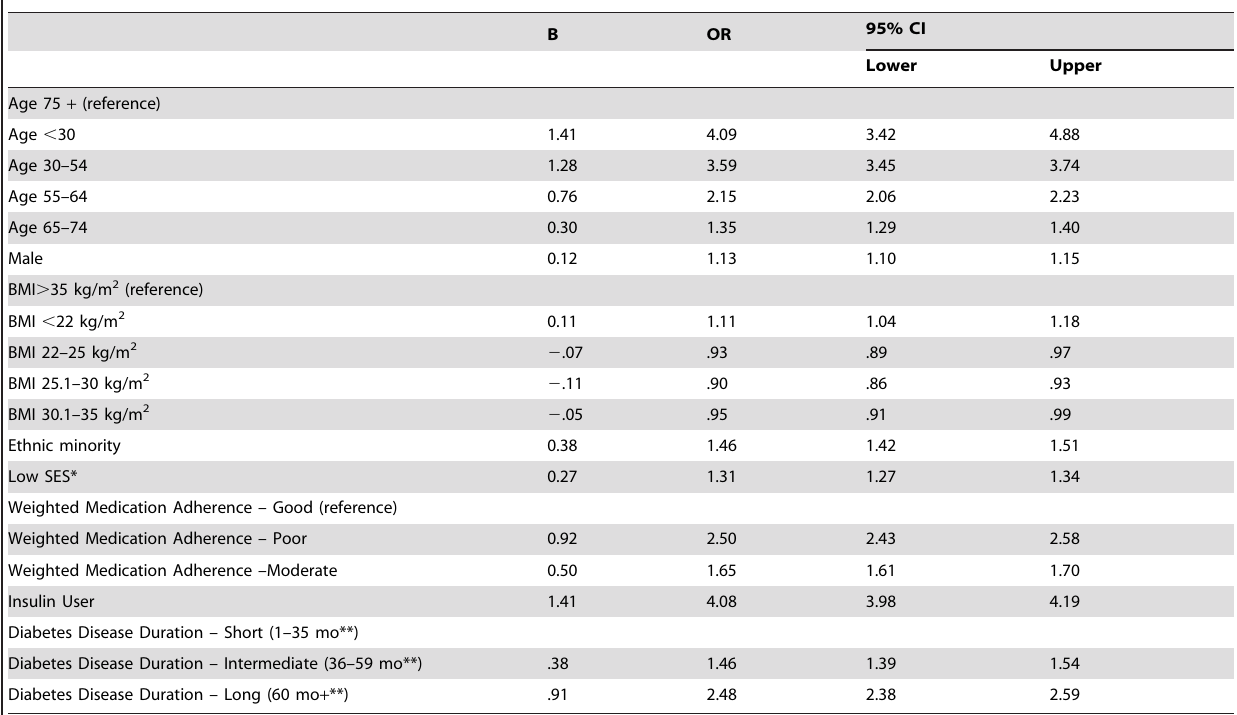
Table 2. Multivariable Regression Analysis for Poor Glycemic Control (HbA1c . 75 mmol/mol